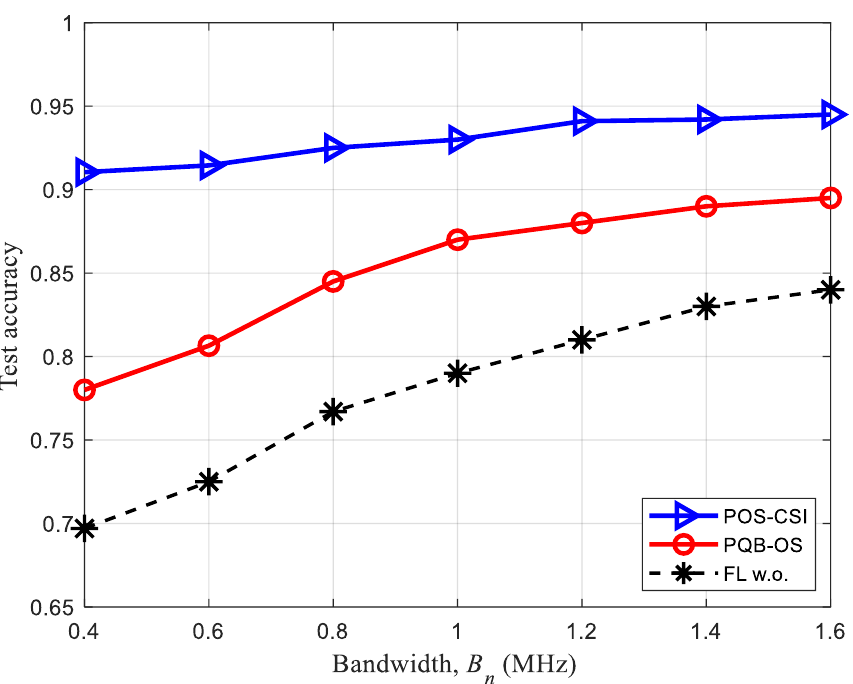
B with Figure 7. Test accuracy performance of different schemes with different bandwidth B n with MNIST